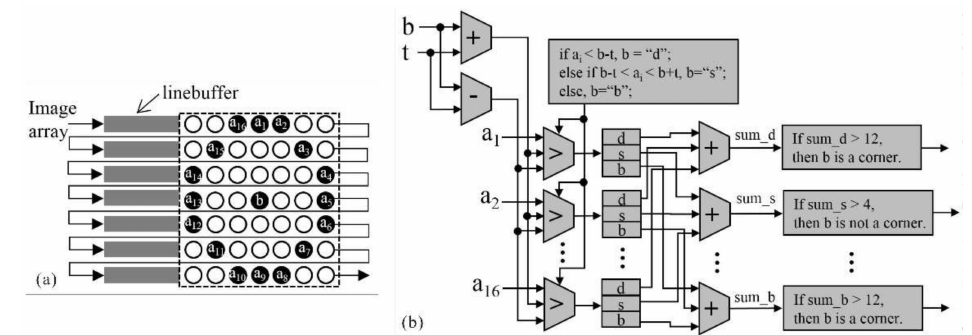
Figure 5. FAST detector module, ( a ) line buffers; ( b ) FAST-12.